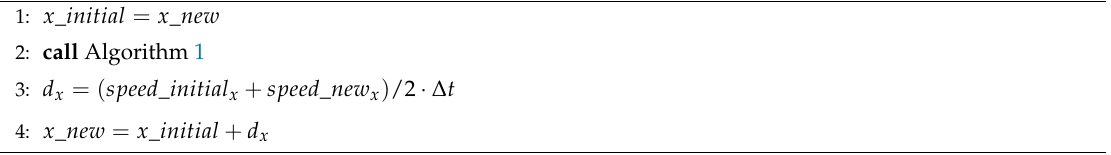
Algorithm 2 Computation of displacement along the x